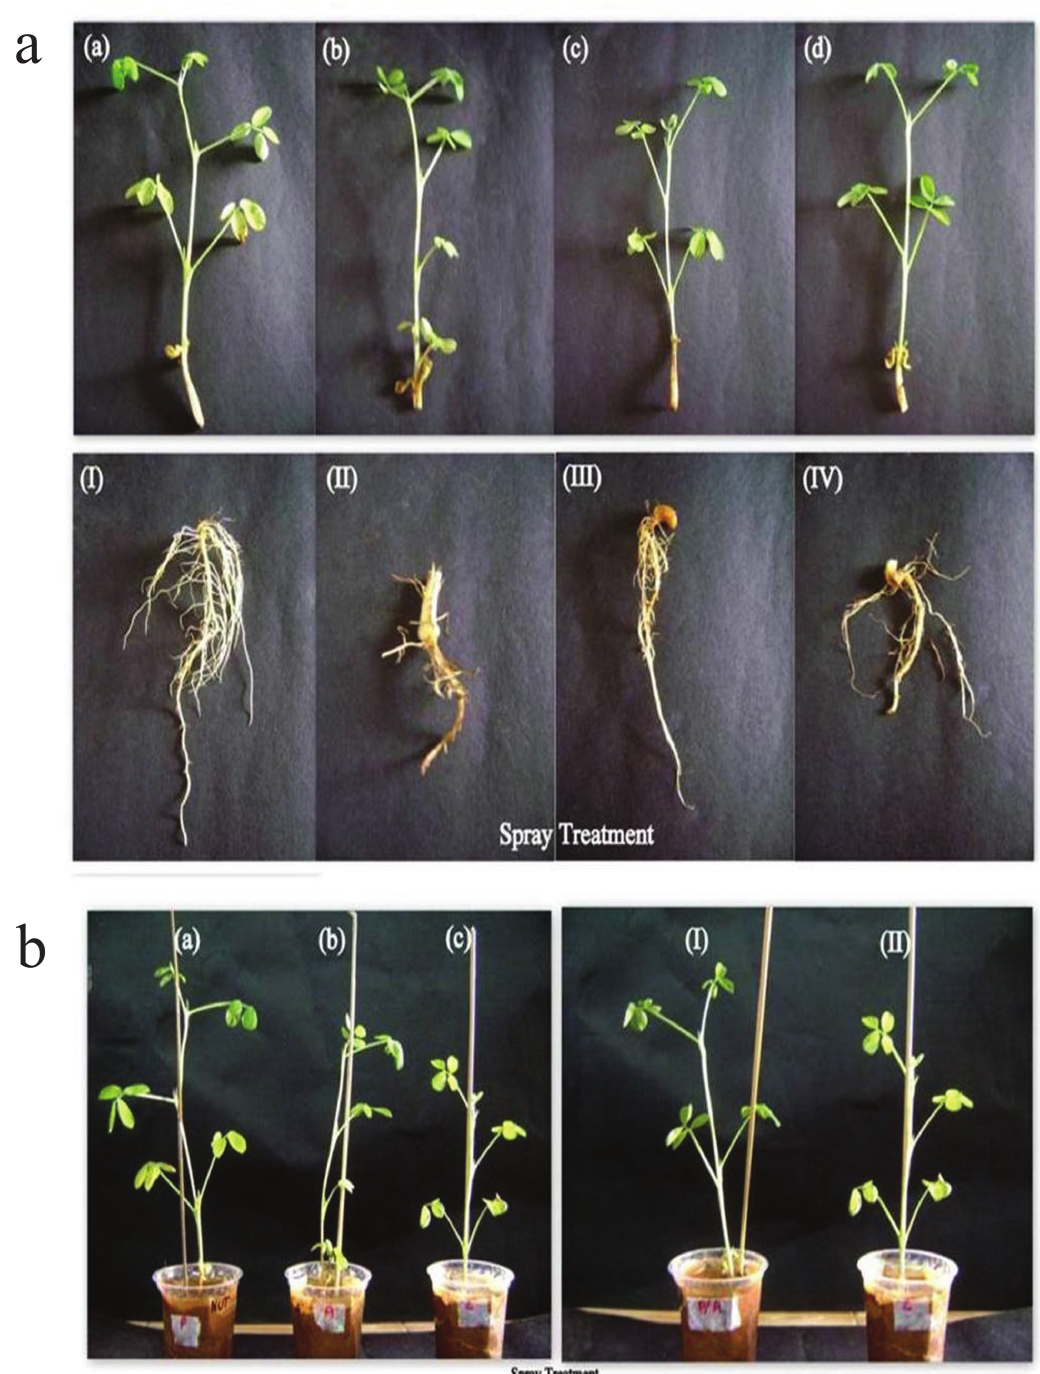
Figure 5 - Growth of groundnut plants under foliar spray treatment with PGPR. a . Root and shoot growth of groundnut under foliar spray treatment with PGPR. (a) and (I) – Control; (b) and (II) – A. brasilense ; (c) and (III) – P. fluorescens ; (d) and (IV) – A. brasilense and P. fluorescens. b . Groundnut plants after foliar spray treatment with PGPR. (a) – P. fluorescens ; (b) – A. brasilense ; (c) – Control; (I) – A. brasilense and P. fluorescens; (II) –